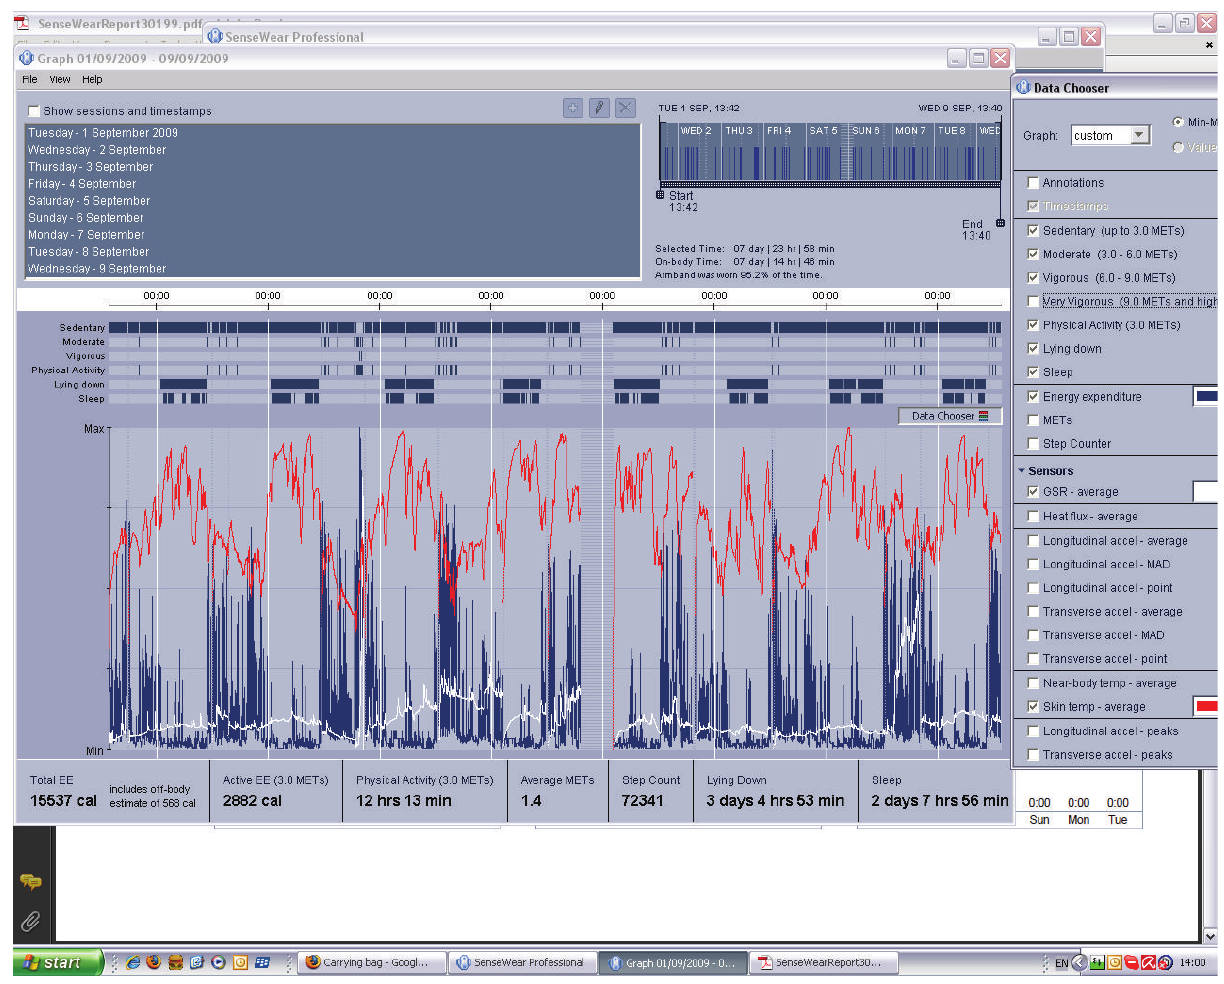
Figure 3: Screenshot of activity and selected sensor readings over one